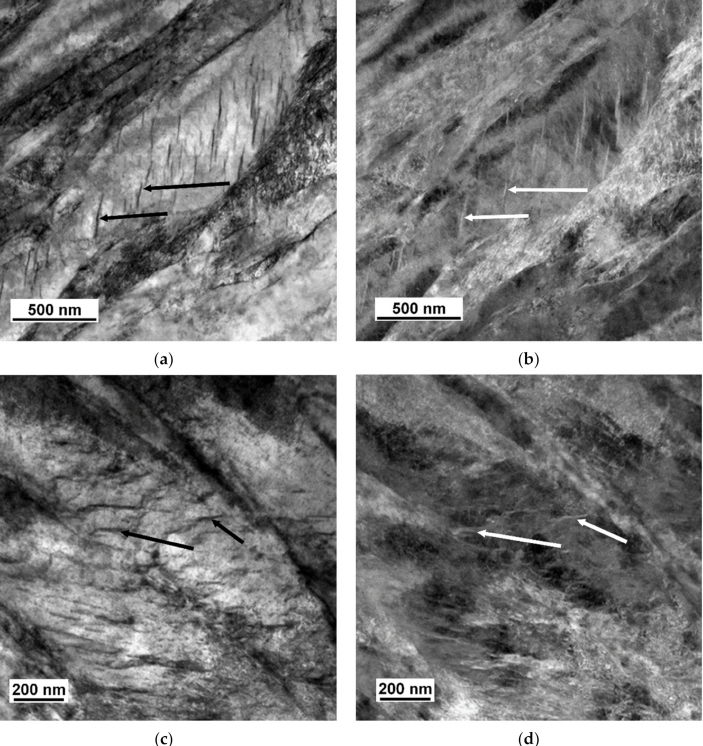
Figure 7. Iron carbides (indicated with black and white arrows) in 42SiCr after tempering at 400 ◦ C